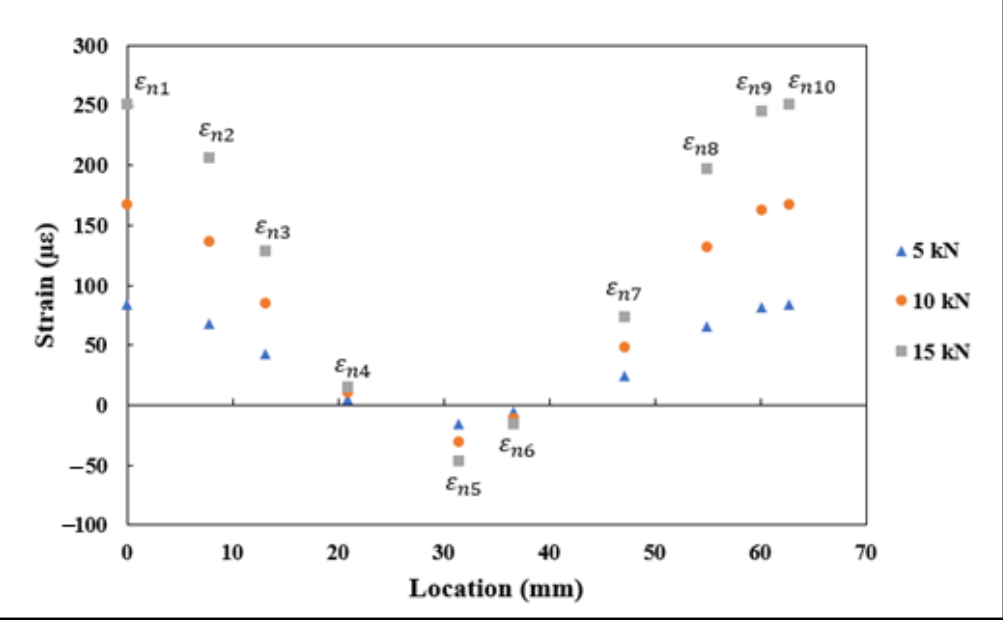
Figure 10. 𝜀 𝑛1 − 𝜀 𝑛10 transformed strains under tensile loading.